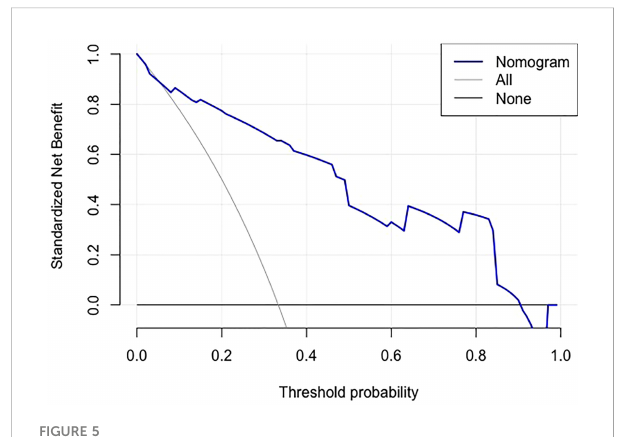
FIGURE 5 Decision curve analysis of the nomogram.The gray line is for all patients with dMMR, the black line line is for no patients were dMMR, and the blue line represents the nomogram model. The graph depicts the expected net bene fi t per patient relative to the nomogram prediction of dMMR risk. The farther the blue line is to the grey and black lines, the better clinical value the nomogram